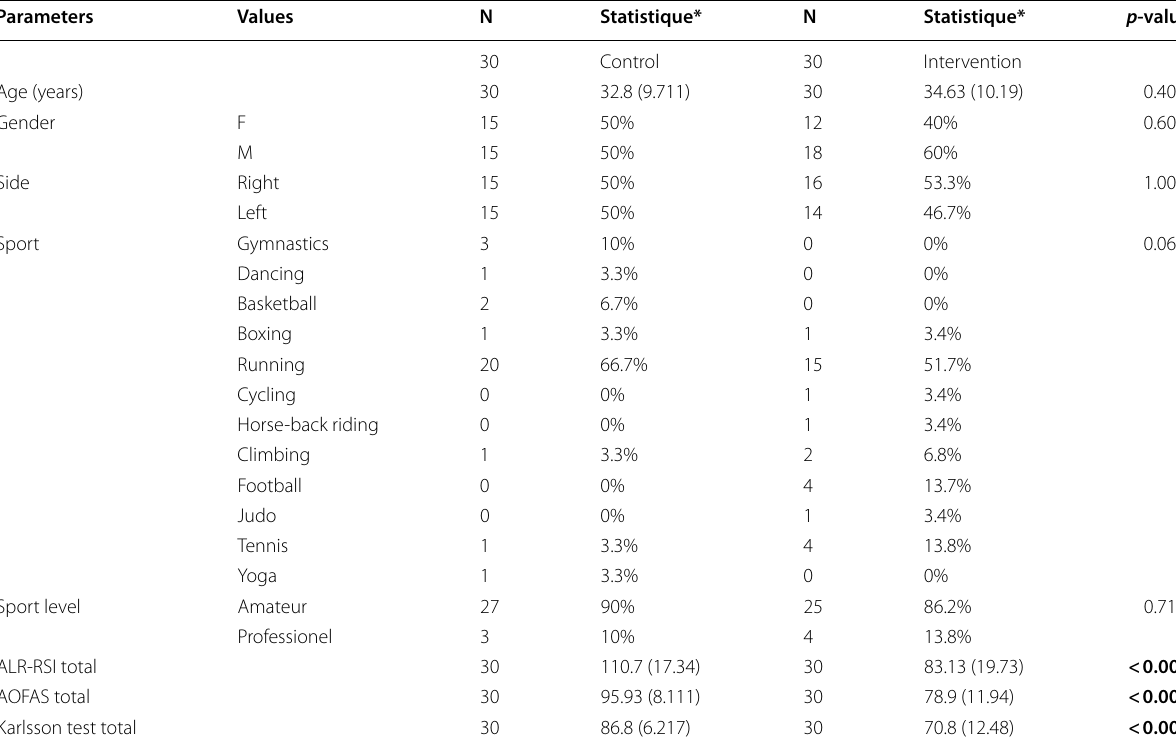
Table 2 Demographic Comparison of the two study populations